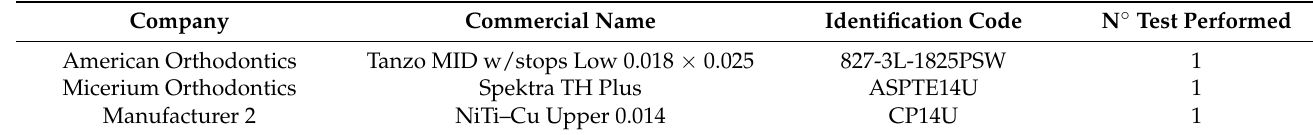
Table 5. Thermal archwires